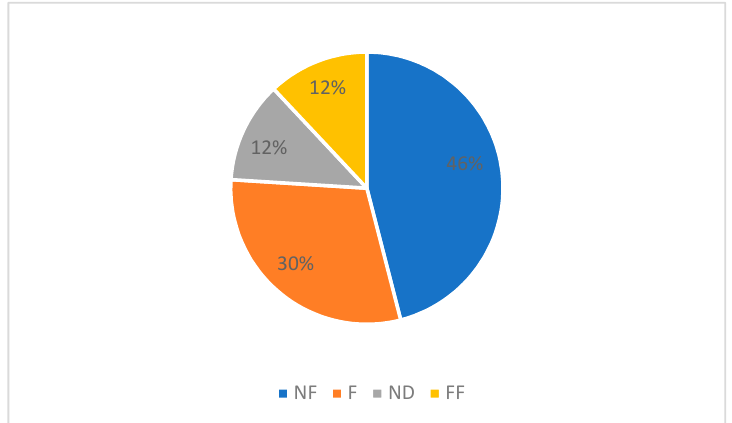
Figure 8. Results of the experiments in the morning for the evening circadian chrono-type.